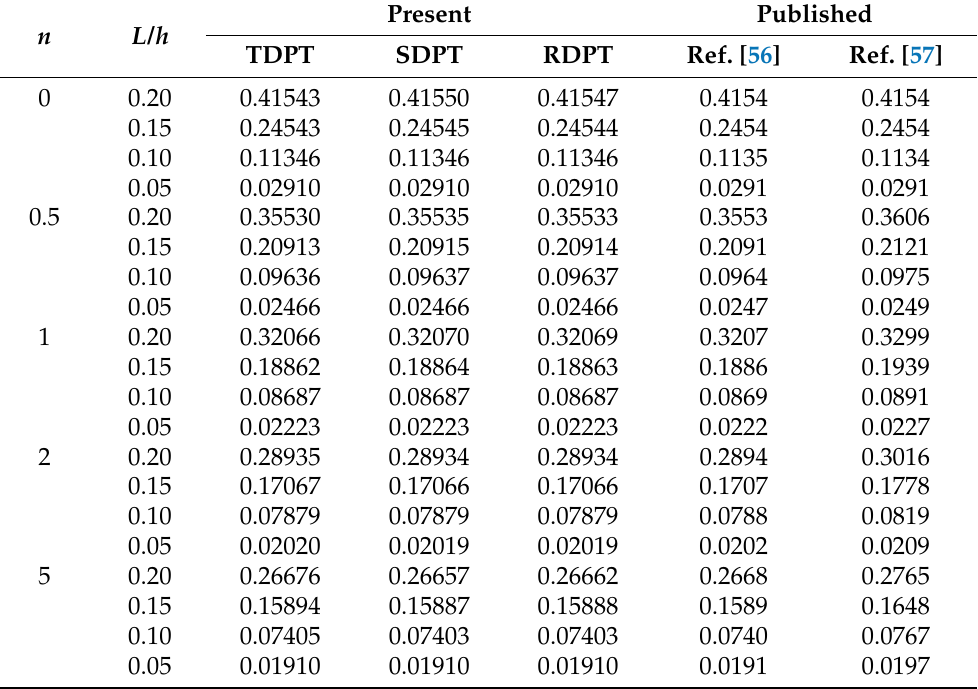
Table 2. Comparison of nondimensional frequency ˆ Ω = h ω foundation ( J 1 = 0, J 2 =